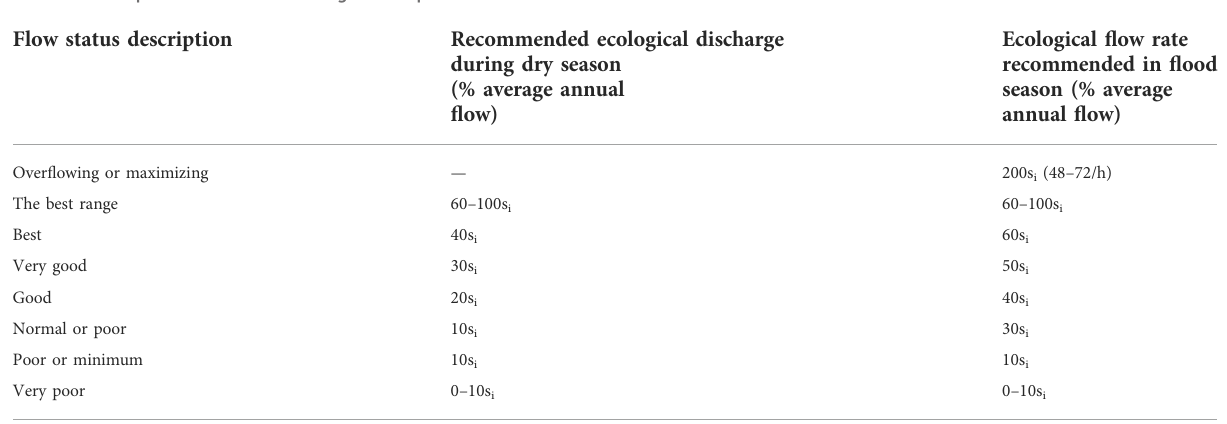
TABLE 1 Description of river fl ow through the improved tennant